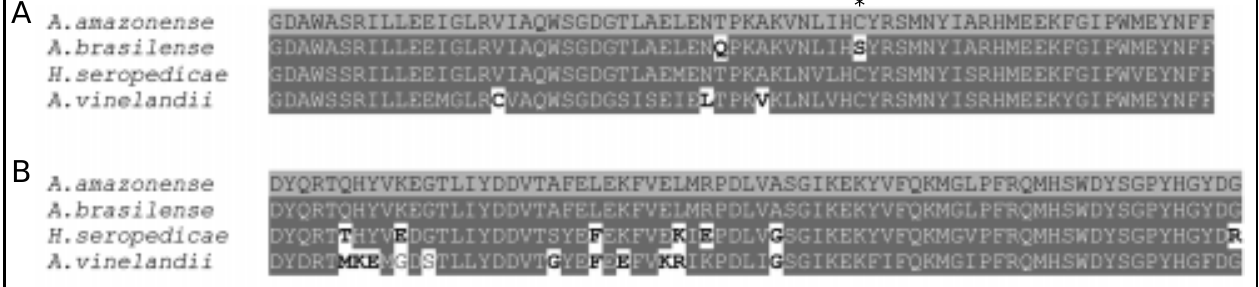
Figure 3. Multiple sequence alignment of the 16S rDNA genes from Azospirillum amazonense (GenBank accession Nos. X79735, Z29616, X79742) and the distantly related A. brasilense Sp7 (GenBank accession Nos. X79732, 79739, 79740). A. amazonense (PCR) represents the PCR DNA sequence obtained in the present study. The primers used here for the PCR amplification experiments are underlined. A black background indicates conserved residues in all aligned sequences, a dark grey background indicates conserved residues in at least 80% of the aligned sequences, and a light grey background indicates conserved residues in at least 60% of the aligned sequences. Multiple alignments were done with the PILEUP program, University of Wisconsin Genetics Computer Group, and the alignment editing was done using the GENDOC program considering the score table Dayhoff PAM 250 (26,27). A